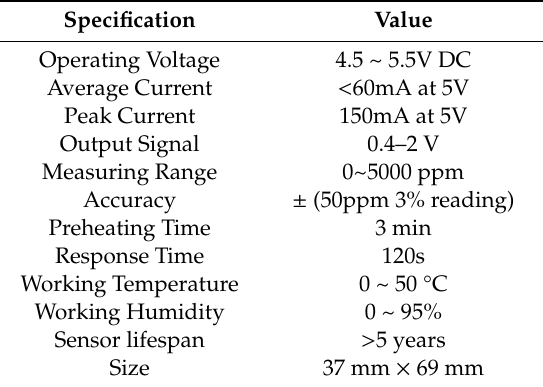
Table 1. MH-Z14 sensor specification.